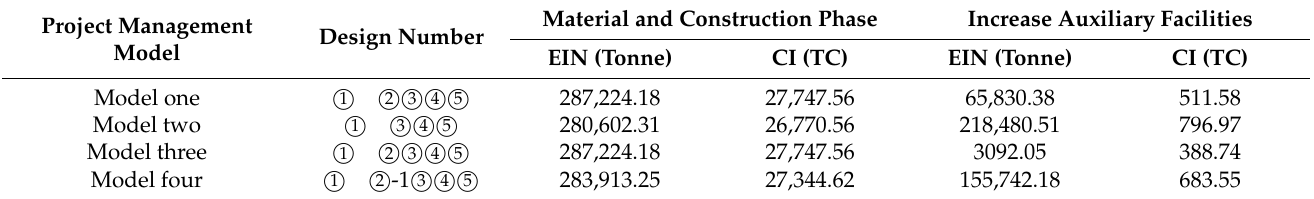
Table 4. Environmental contribution and economic cost of four design options.